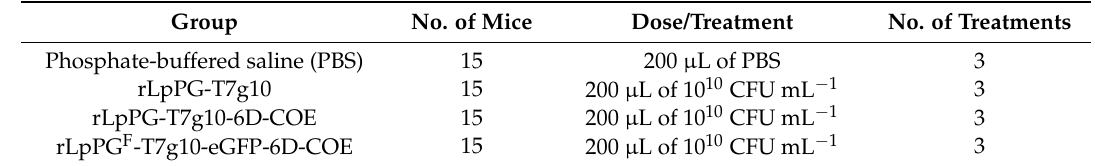
Table 3. Groups and immunization